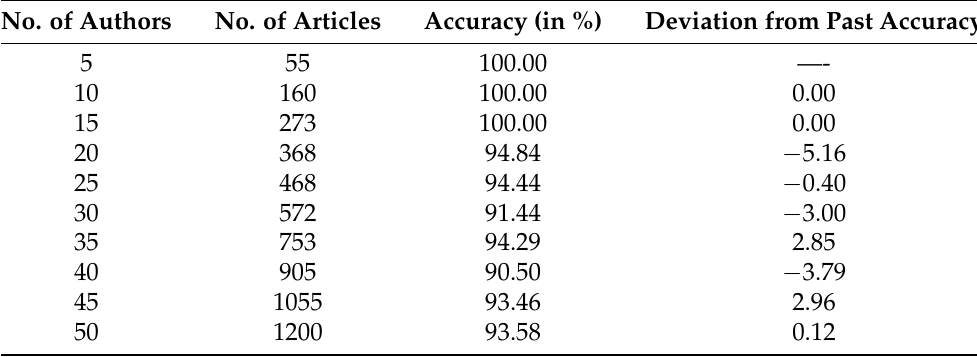
Figure 11. The inter- and intraclass similarity analysis. In this figure, four instances of four different authors are shown (( a )–( d ) from Bankim Chandra Chattopadhyay; ( e )–( h ) from Rabindranath Tagore; ( i )–( l ) from Suchitra Bhattacharya; and ( m )–( p ) from Sunil Gangopadhyay). It can be observed that the interclass similarity is quite high among the authors. There is also a high similarity between different authors such as ( d ) and ( h ) marked in orange boxes, ( j ) and ( n ) marked in red boxes, and ( l ) and ( p ) marked in green boxes, which leads to confusion. Furthermore, an intraclass difference is observed, adding more challenge to our task: the difference can be observed for the pairs ( c )–( d ), ( e )–( f ), ( i )–( j ), and ( n )–( o ), all pairs from the same author, which further adds to the chances of misclassification. Table 10. The results obtained for the partitioned